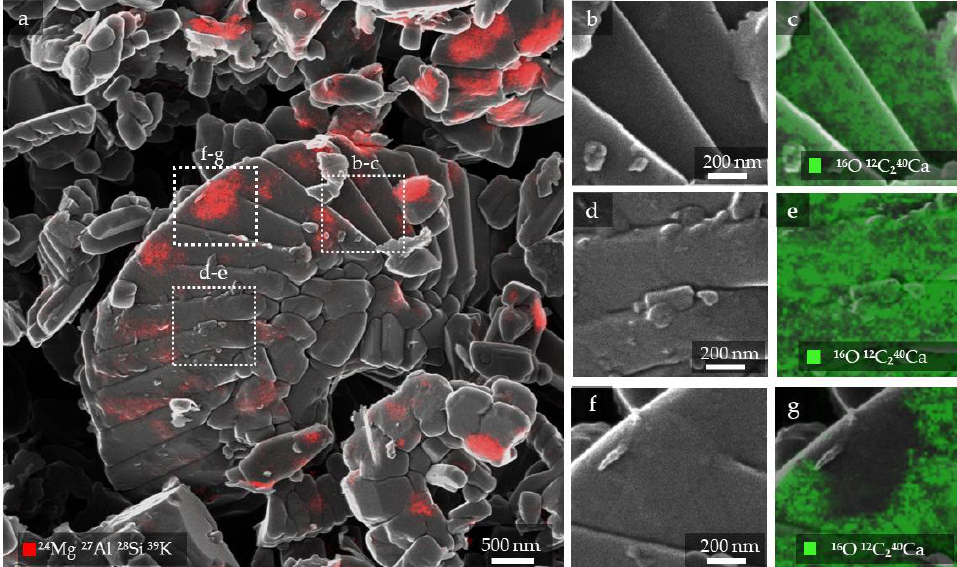
Figure 5. SE images with identified calcite distribution versus clay coating linked to topography of the coccolith grain and fragments. ( a ) The SE image is overlayed by the coinciding distribution of ²⁴Mg, ²⁷Al, ²⁸Si, and ³⁹K in red, representing clay. Three white boxes are marked and presented with increased magnification to highlight surface topography versus chemistry ( b – g ). ( b ) Smooth, yet stepwise surface ( c ) with distribution of 16 O, 12 C₂, and 40 Ca in green combined with the correspond- ing SE image. ( d ) Irregular surface. ( e ) The irregular surface in ( d ) is identified as calcite. ( f ) SE image with smooth surface which covers and evens out the steplike structure. ( g ) The overlay of ( f ) with the SIMS image presents a calcite dominated